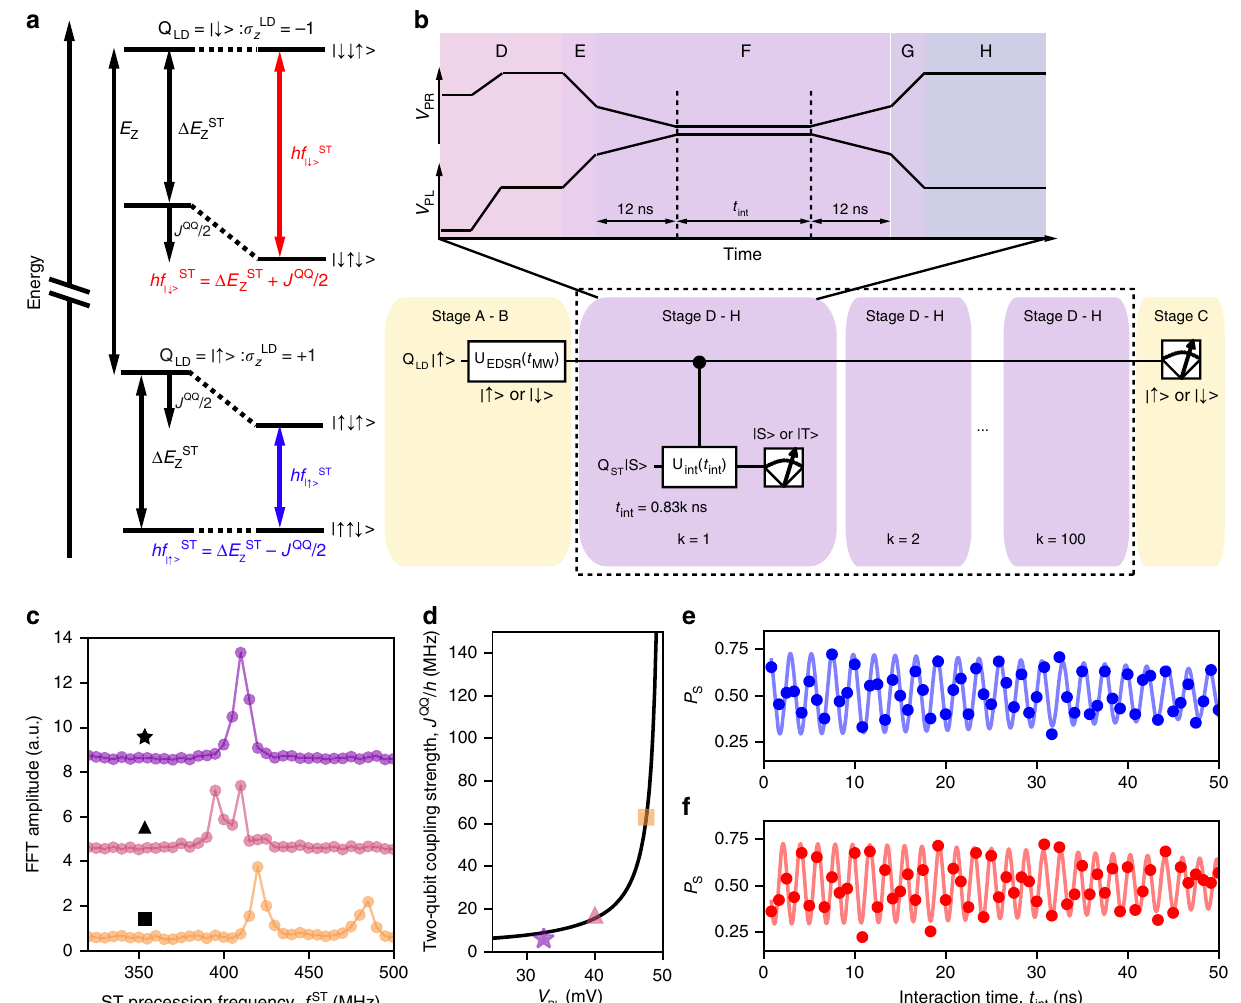
(cid:1) Δ E ST ; Δ E QQ (cid:1) J QQ ( J ST = 0). The ST qubit Z Z Z is also Z ↑ 〉 fi tted with LD input state |